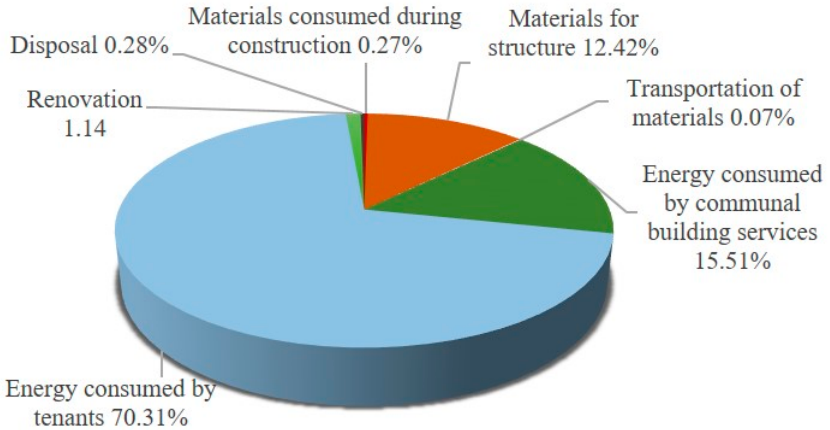
Figure 3. Contribution to the GHG emissions of the sampled housing block.